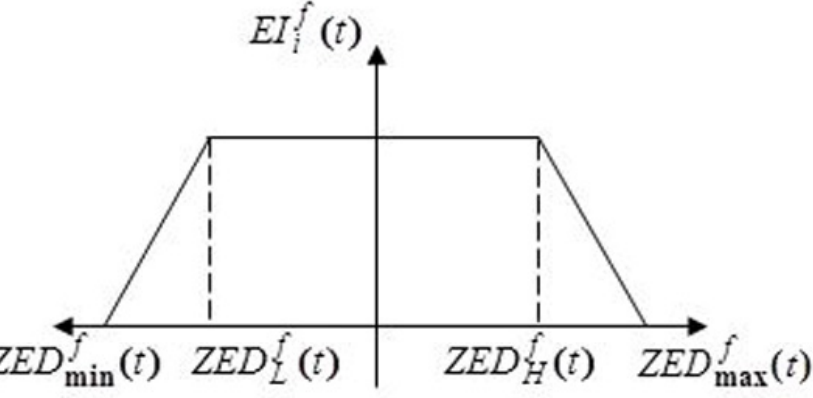
Figure 1. The curve of the single environmental impact metric